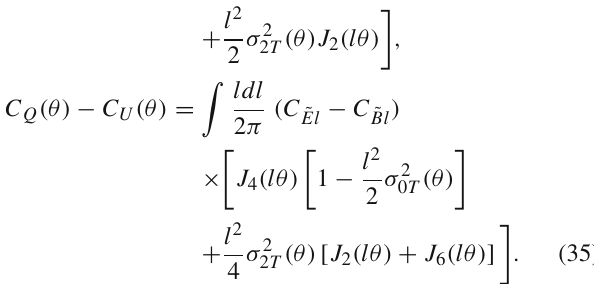
due to dipole is also plotted on right side vertical 2 π